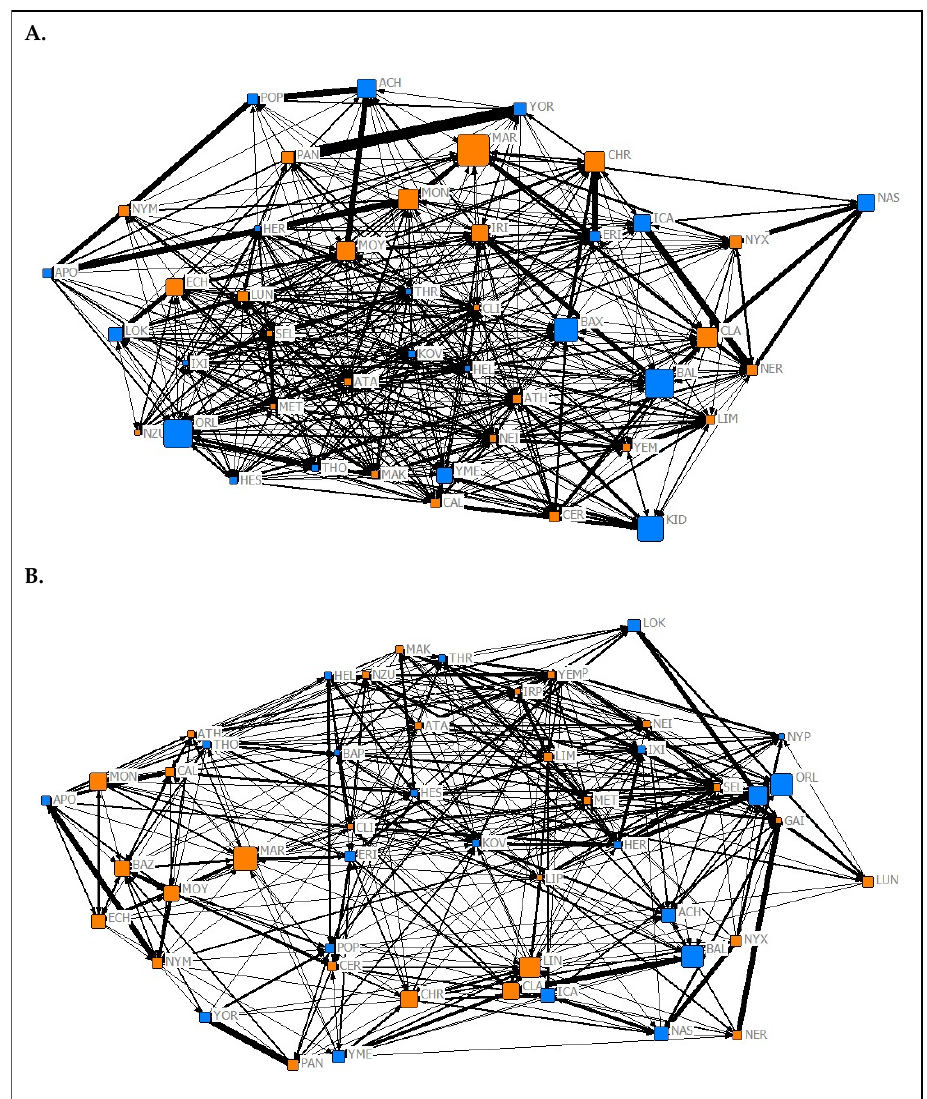
Figure 1. Graphical representations of the observed association networks from ( A ) Summer 2019 and ( B ) Spring 2020 of captive P. livingstonii created in the UCINET 6 visualisation tool NetDraw [39]. Nodes are labelled with their assigned three letter codes. Blue nodes denote male individuals, and orange denote females. The size of each node corresponds to the age in years of the individual during respective data collection periods with older individuals being represented by larger nodes. The width of each tie increases with the weight of the edge. Non-metric geo-distances with node repulsion were used to create the layout, meaning nodes with more similar ties are closer together and nodes that are more central to the network are placed closer to the centre of the graph.